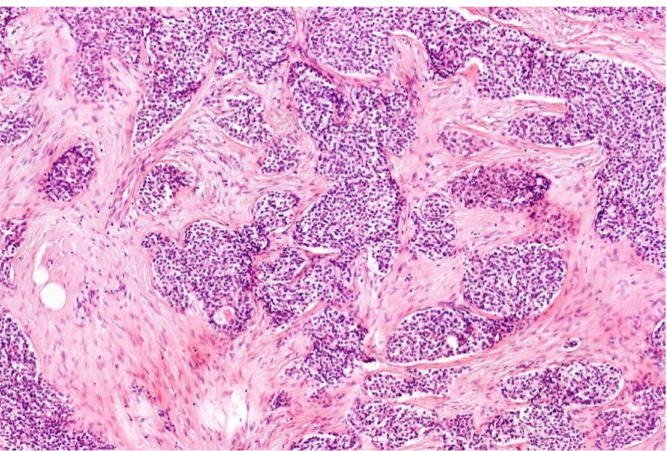
Figure 4. Small, blue, round cells situated in a desmoplastic stroma is characteristic for DSRCT (HE; 20 × magnification).